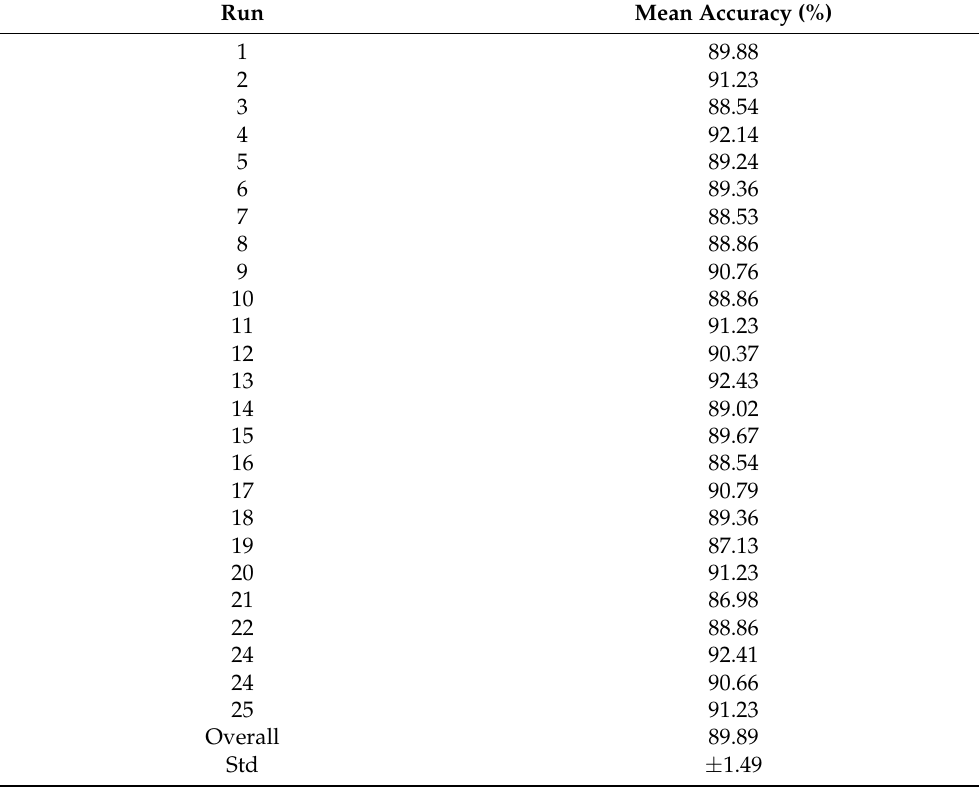
Figure 6. Visualized results for COVID-19 detection. Train-validation accuracy and loss over the training epochs and AUC scores for the classes are presented in the top graph. Selected output images of the Grad-CAM implementation are visualized. Each dashed-line box presents a true class, while the green and red boxes distinguish between correctly classified samples and mistakes, respectively. Table 4. Classification results of 25-run 10-fold cross-validation when training and testing MobileNet (v2) using the COVID-19 detection dataset (two